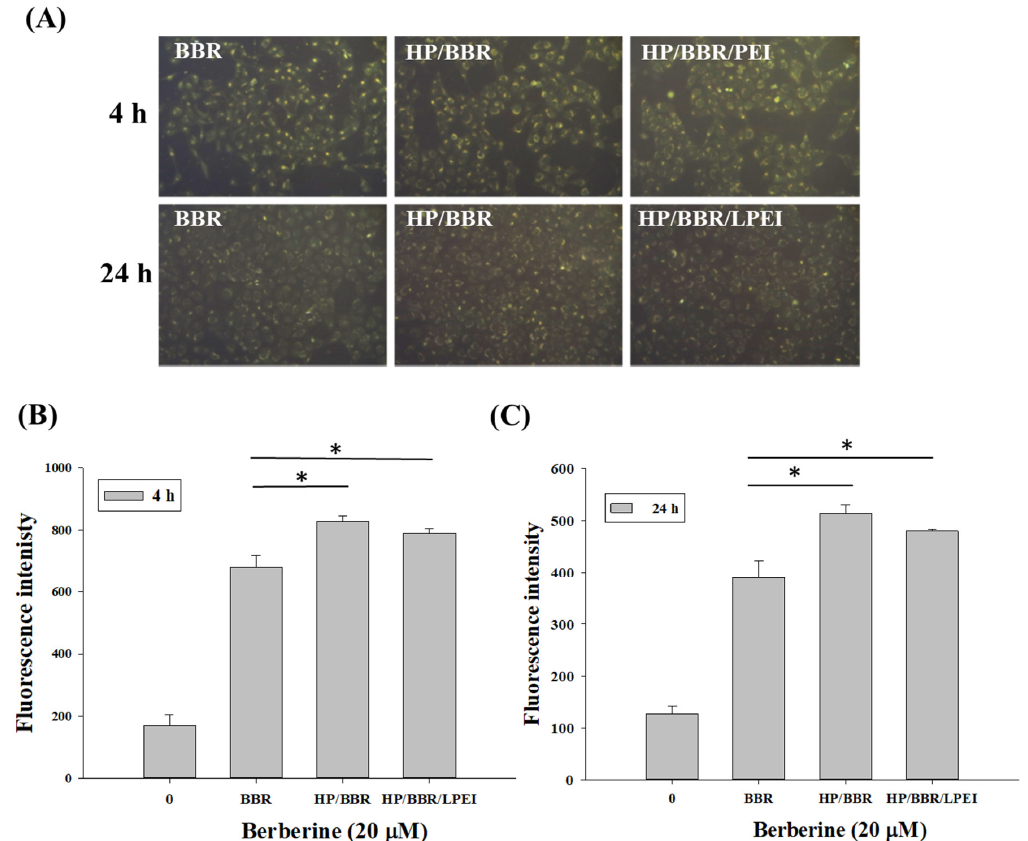
Figure 4. Cellular uptake of BBR, HP/BBR nanoparticles, and HP/BBR/LPEI nanoparticles containing 20 µ M BBR in U-2 OS cells after 4 or 24 h treatments. ( A ) The uptake of BBR, HP/BBR nanoparticles, and HP/BBR/LPEI nanoparticles in U-2 OS cells measured by flow cytometry after 4 h ( B ) and 24 h ( C ) of treatment. * p < 0.05 significant difference between BBR-treated groups and the control as analyzed by one-way ANOVA. 2.5. Cell Cycle Distribution of U-2 OS Cells Treated With Berberine and Berberine Nanoparticles.